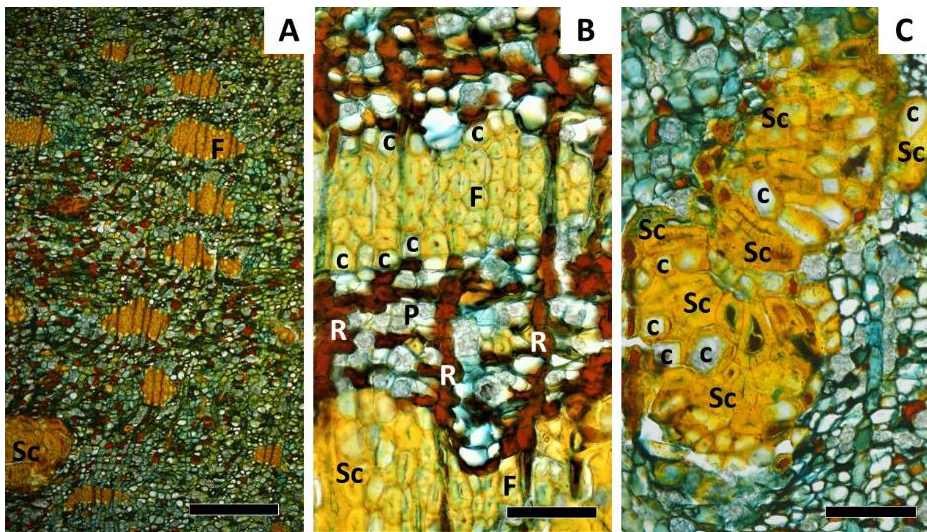
Figure 4. Transverse section of the nonconducting secondary phloem of Quercus rotundifolia . ( A ) Tangential groups of fibers (F) and groups of sclereids (Sc). ( B ) fibers (F) in tangential groups bordered by crystals (c); thin rays filled with extractives (R); nonlignified axial parenchyma cells (P) and sclereids (Sc). ( C ) Group of sclereids (Sc); these cells are strongly lignified with thickened walls and sometimes enclose a large prismatic crystal (c) and phenolic compounds (dark staining). Scale bar: A = 200 μm; B = 80 μm; C = 65 μm.